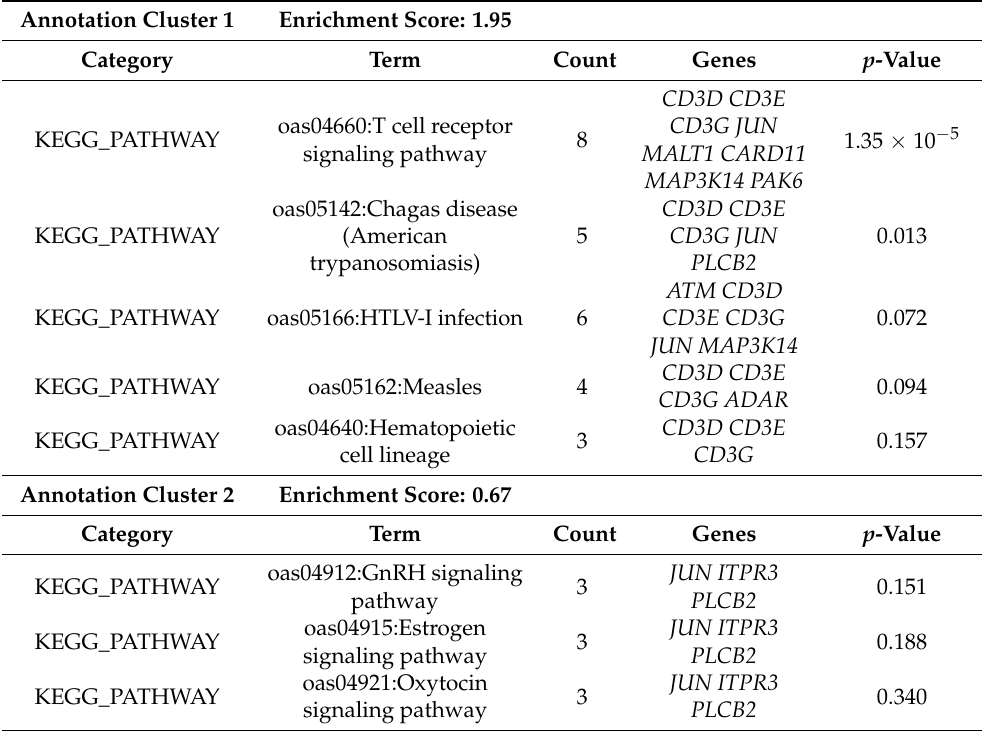
Table 1. The functional annotation clusters of similar biological meanings sharing common gene members enriched by